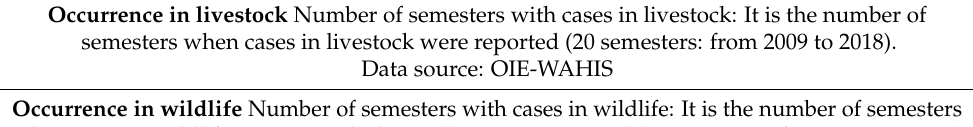
Table 2. Overall listing of variables considered to build the GLMMs and their description. Occurrence in livestock Number of semesters with cases in livestock: It is the number